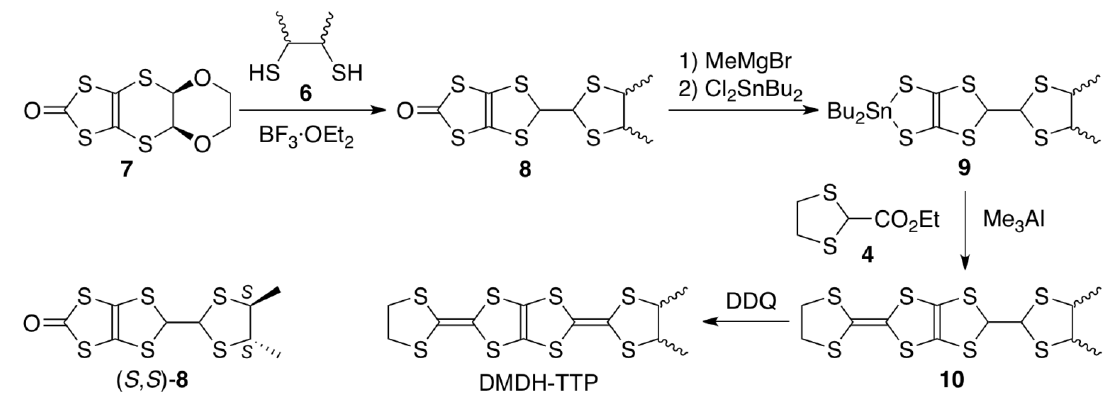
, PF and BF salts of 6 6 4